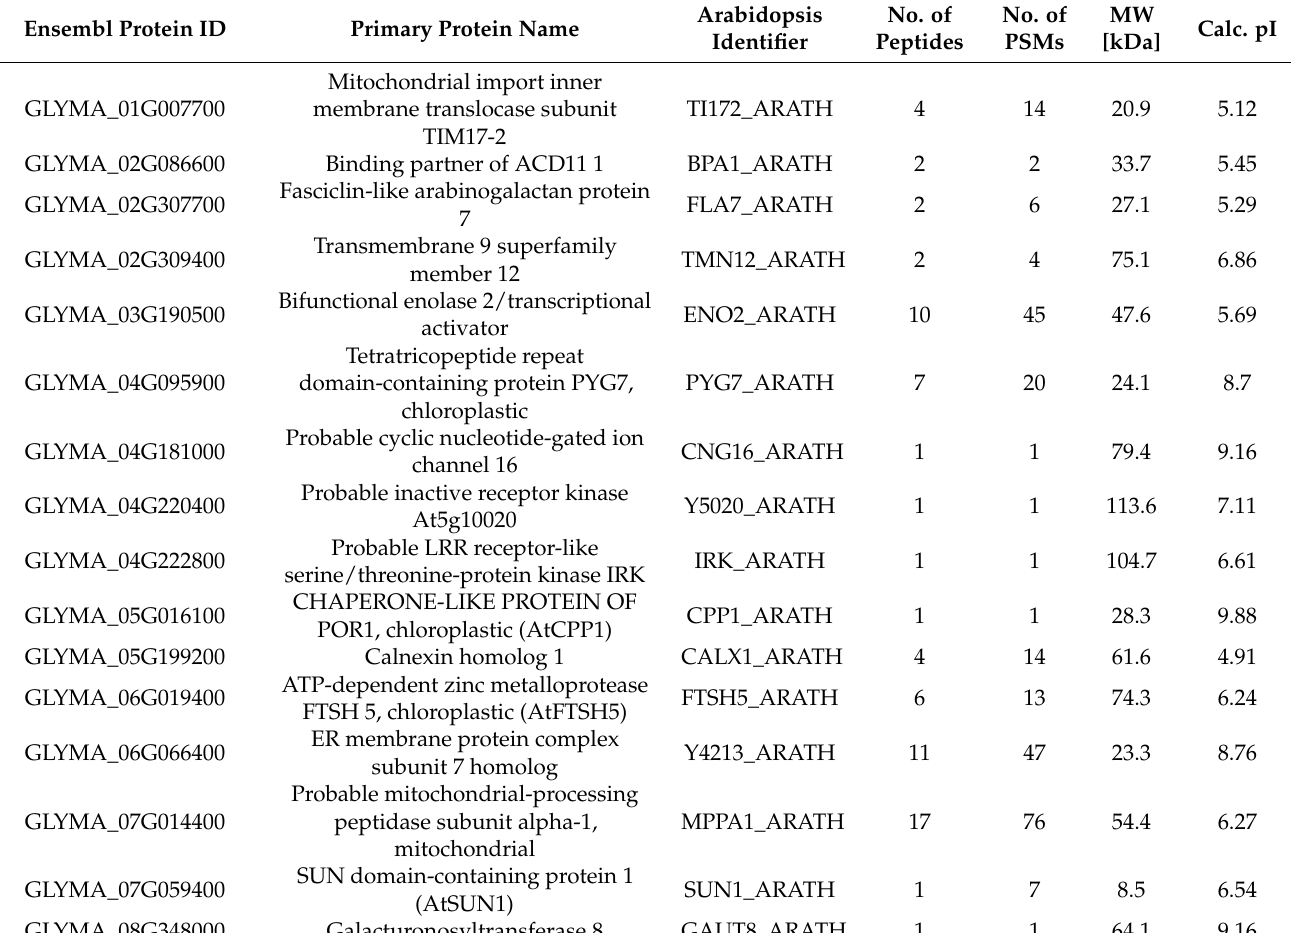
Table 4. Down-regulated membrane proteins under salt stress in soybean